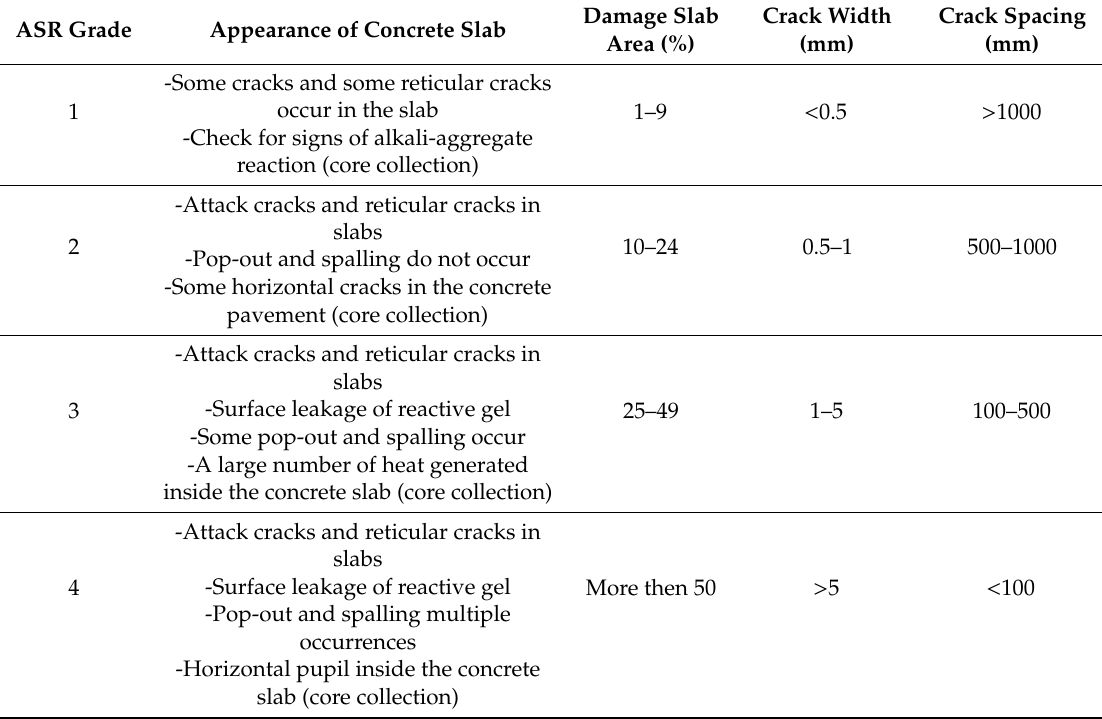
Table 2. The damage caused by alkali-silica reaction (ASR) in concrete slab with respect to ASR grade. ASR Grade Appearance of Concrete